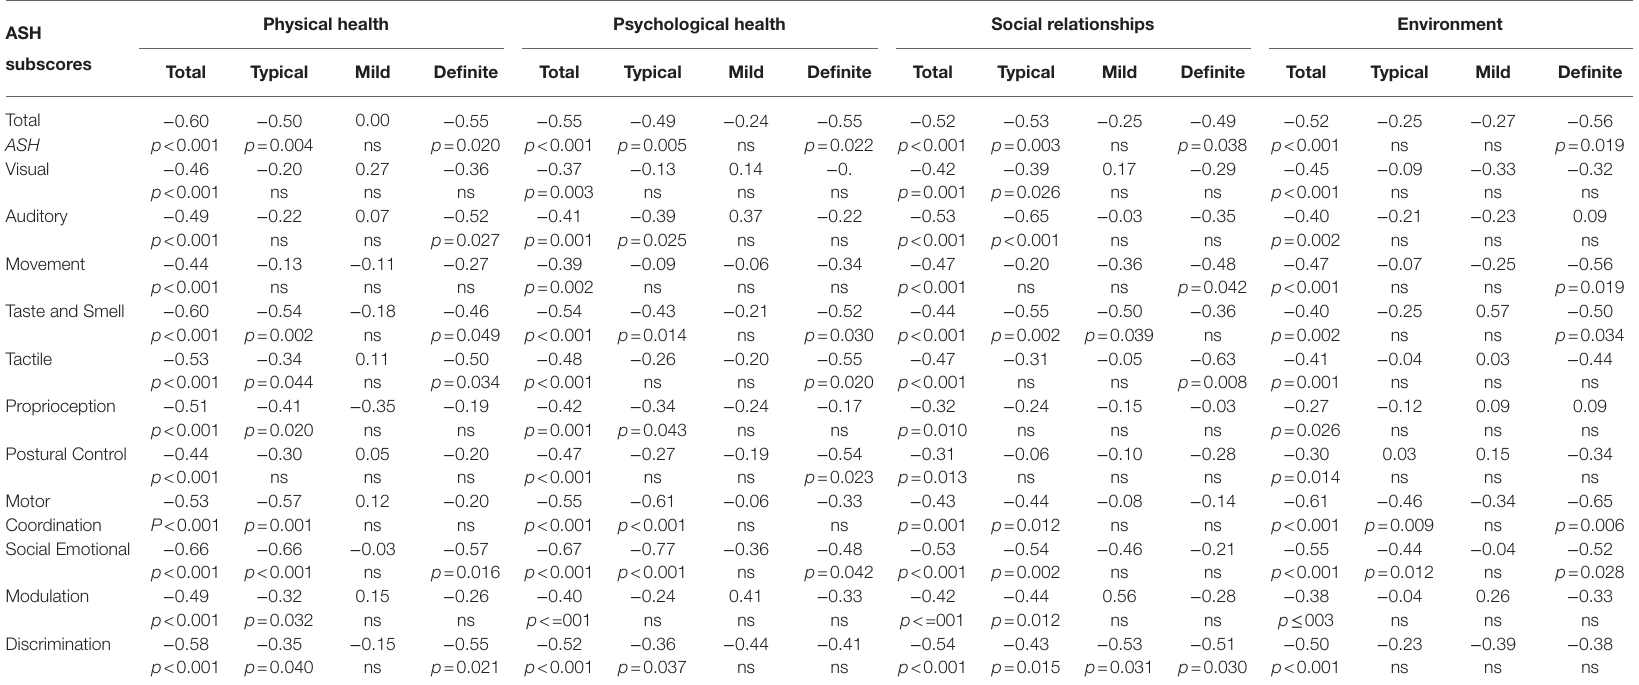
TABLE 4 | 1-tailed Pearson correlations of adult QOL on WHOQOL-BREF and sensori-motor functions on ASH ( N = 53). Physical health Psychological health Social relationships Environment ASH subscores Total Typical Mild Definite Total Typical Definite